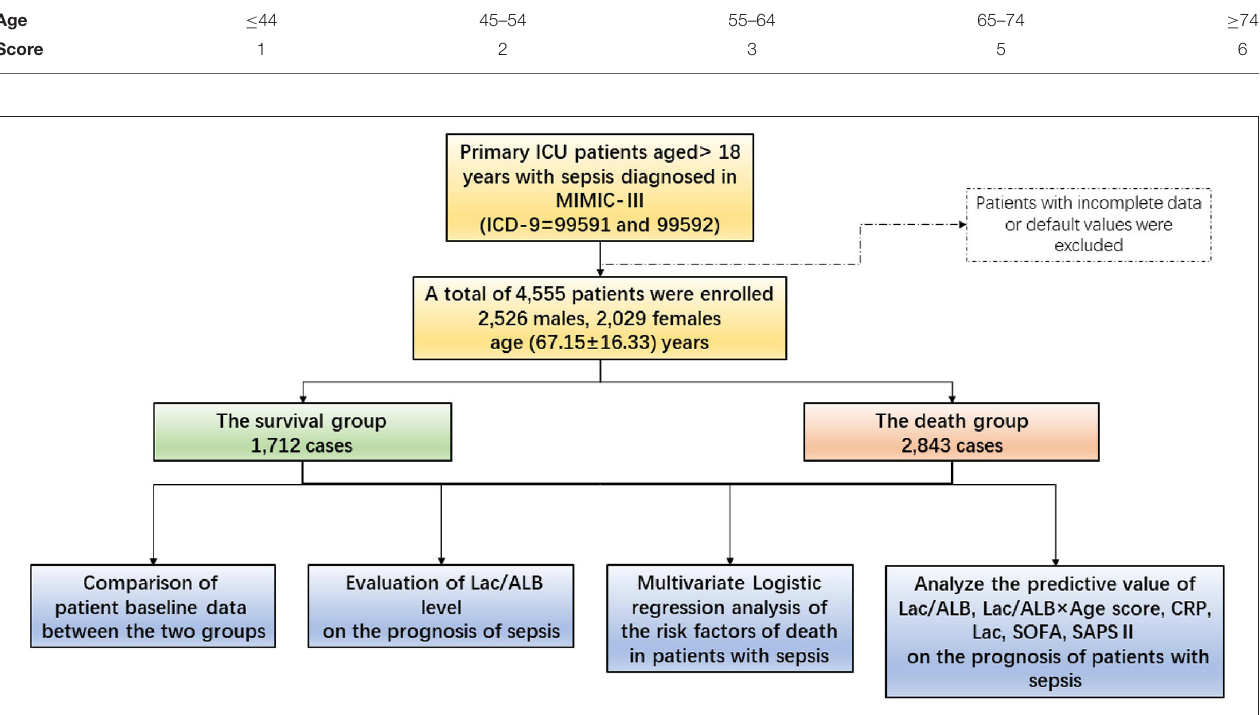
FIGURE 1 | Graphical abstract of the